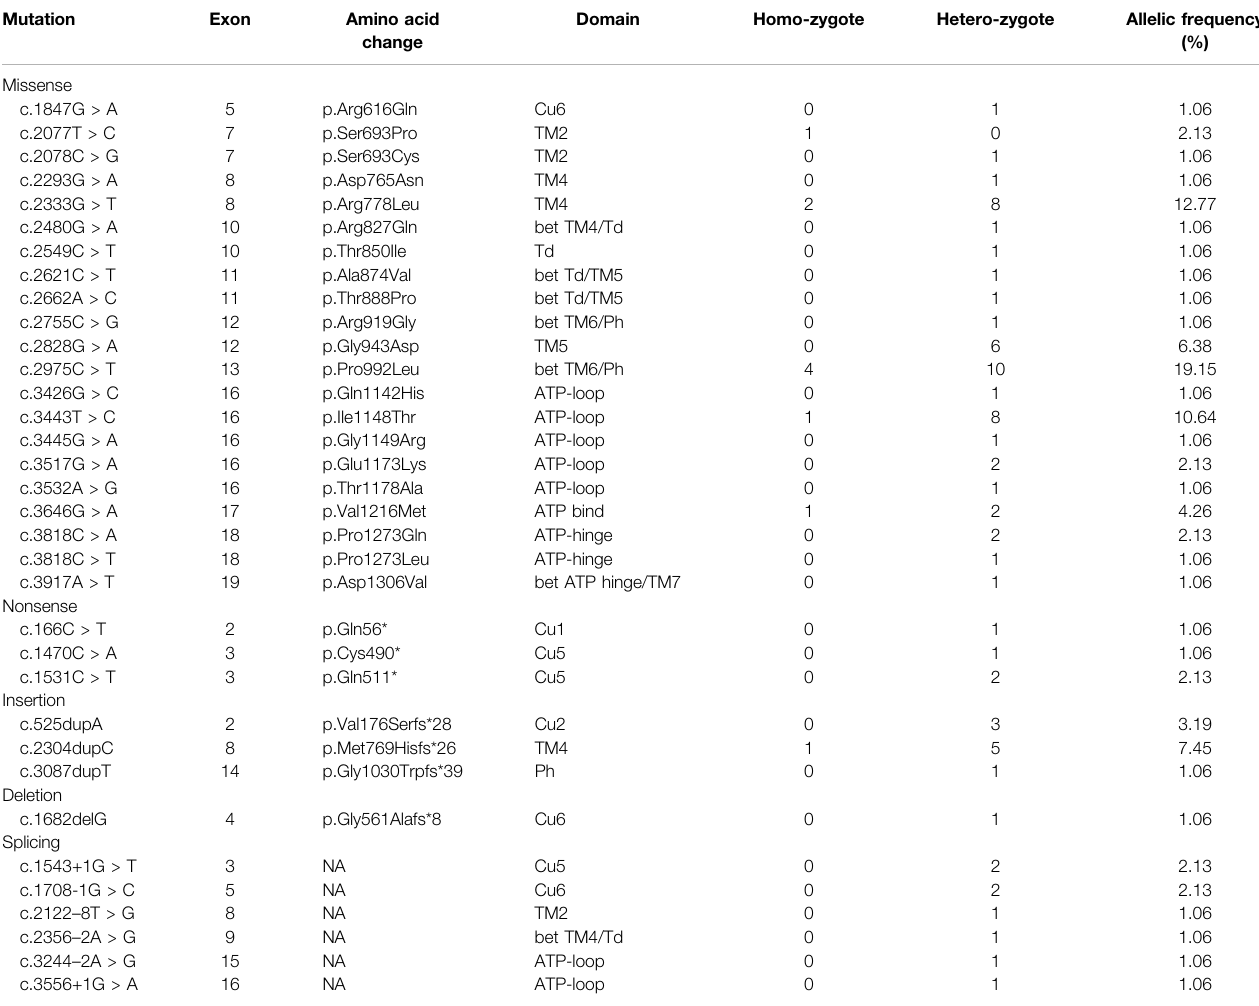
TABLE 3 | Spectrum and frequency of ATP7B gene mutations in 47 neurological WD patients. Mutation Exon Amino acid Domain Homo-zygote change